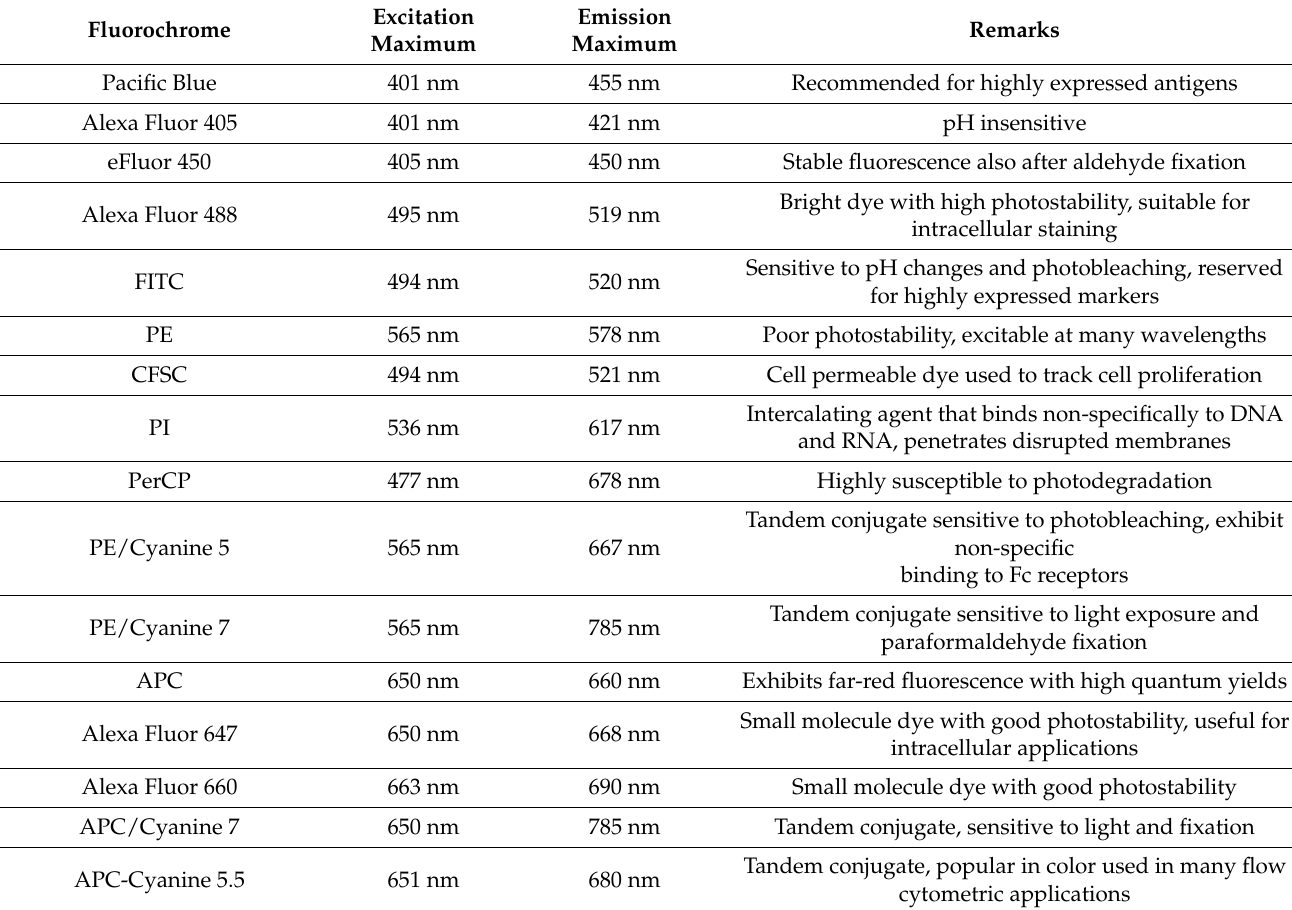
Table 2. Representative fluorochromes used for flow cytometry.